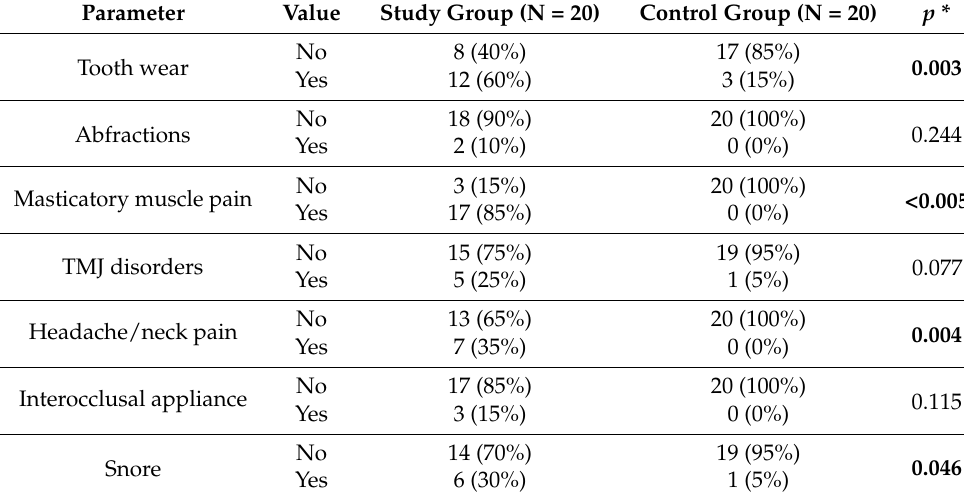
Table 7. Clinical signs representing manifestations of